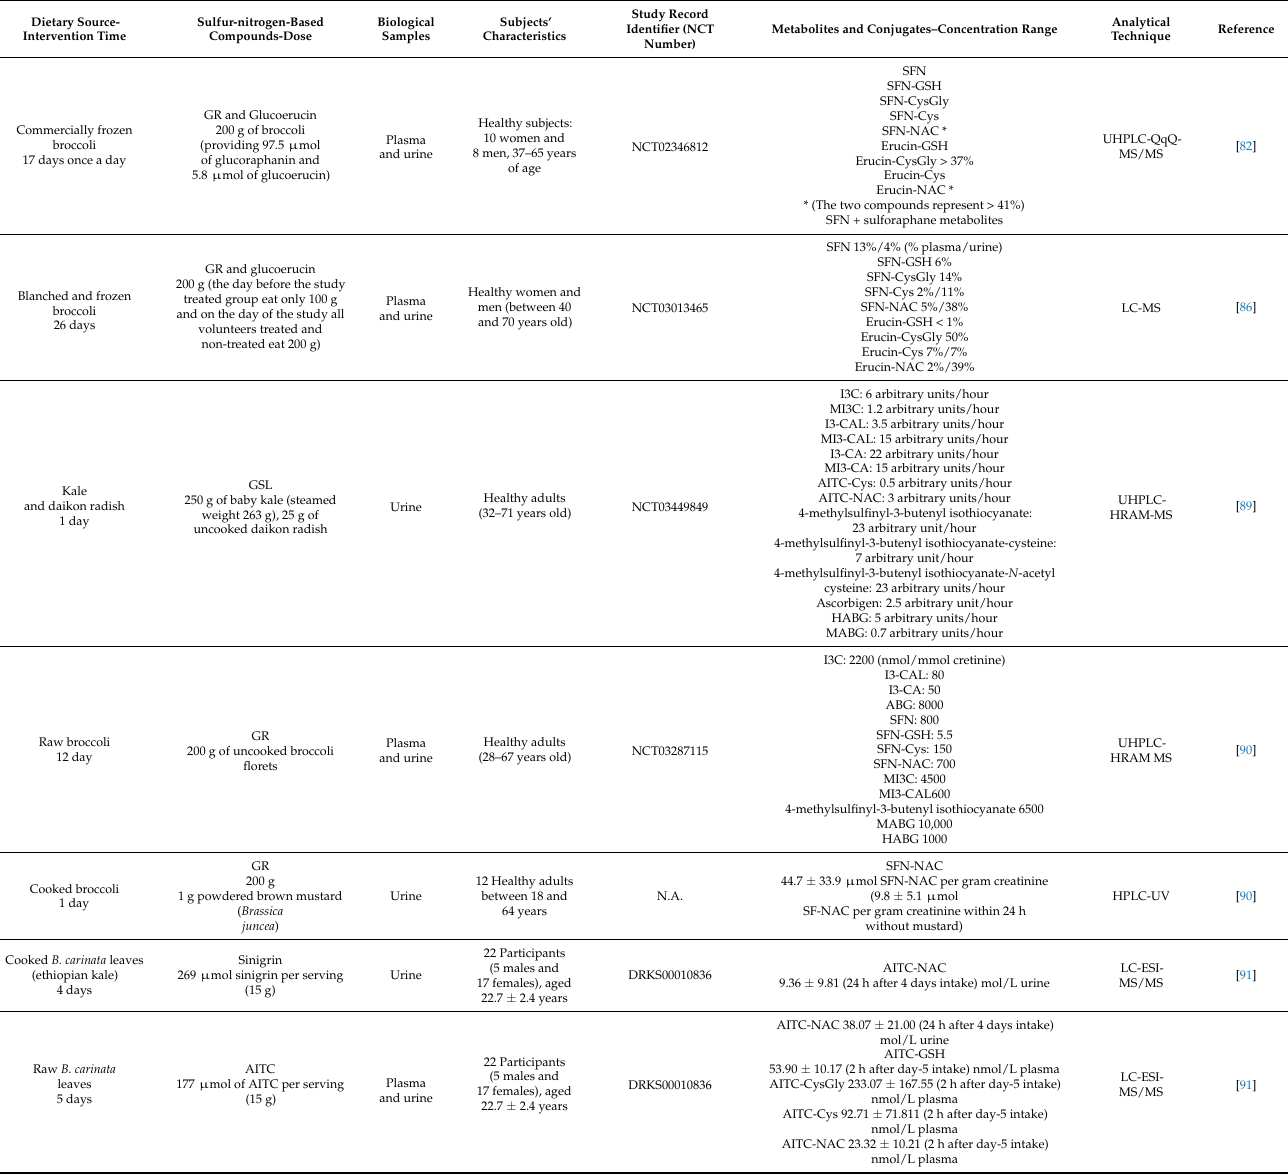
Table 3. Dietary interventions using mature cruciferous vegetables and derived